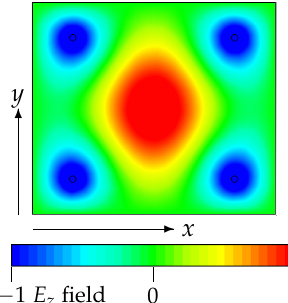
Figure 12. Field variation of a longitudinal modes in a 2 × 2 array of uniform infinitely long wires in a waveguide. The distances between the wires are given by L x = 15 mm and L y = 13.06 mm. The single period of the longitudinal electromagnetic wave is given by L z = 80.6 mm. The dimensions of the waveguide are given by S x = 52.5 mm and S y = 45.7 mm. Thus, the distances of the wires closest to L x and 1 L y . Here the longitudinal component E z in the ( x , y ) the waveguide walls and the walls are 1 4 4 plane is shown.